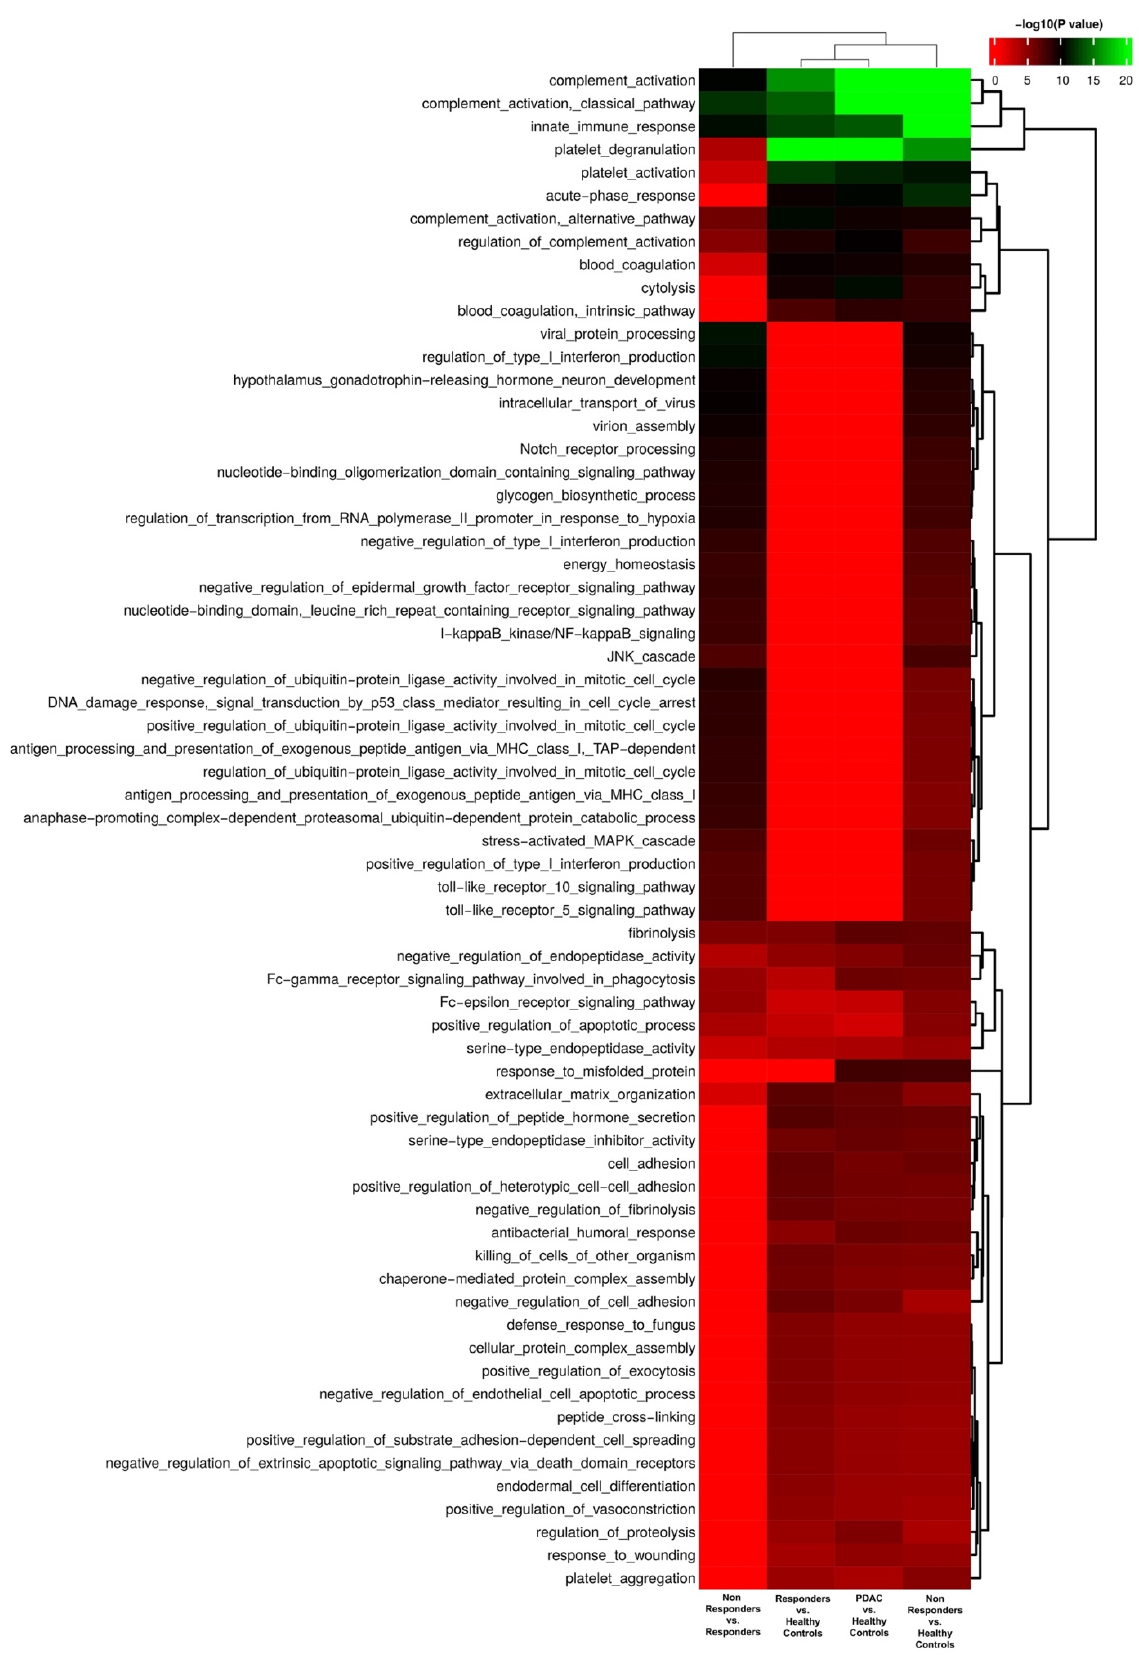
Figure 3. Functional enrichment of significantly regulated EV proteins based on biological pro- cesses.